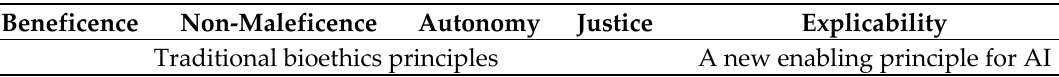
Table 2. Evaluation model proposed by Floridi and others.